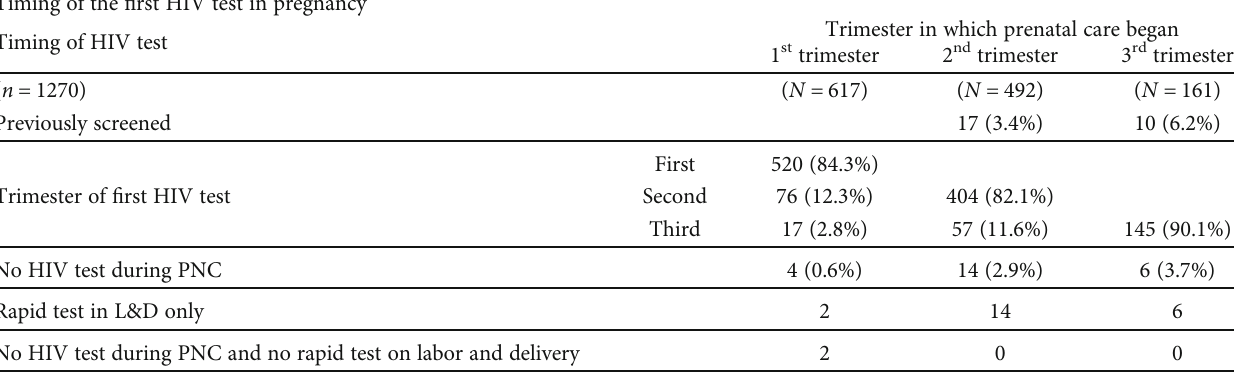
Table 2: Trimester of initiation of prenatal care vs fi rst HIV screening test. The trimester during which the fi rst HIV test was documented was identi fi ed and compared to the trimester during which prenatal care was initiated for all patients meeting inclusion criteria. HIV screening occurring in the trimester of initiation of prenatal care signi fi es early HIV screening in pregnancy. PNC =prenatal care: 1270.